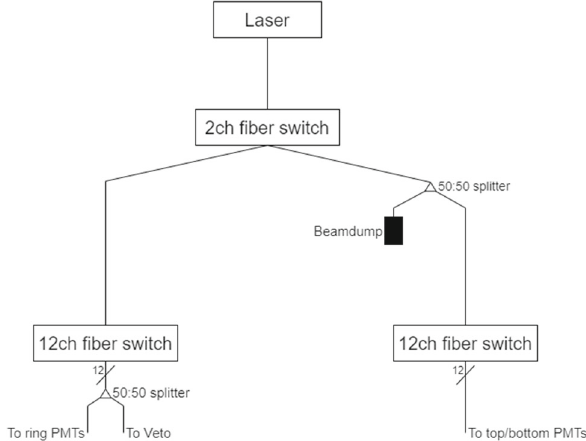
Fig. 10 Routing scheme of the light distribution system for the cali- bration